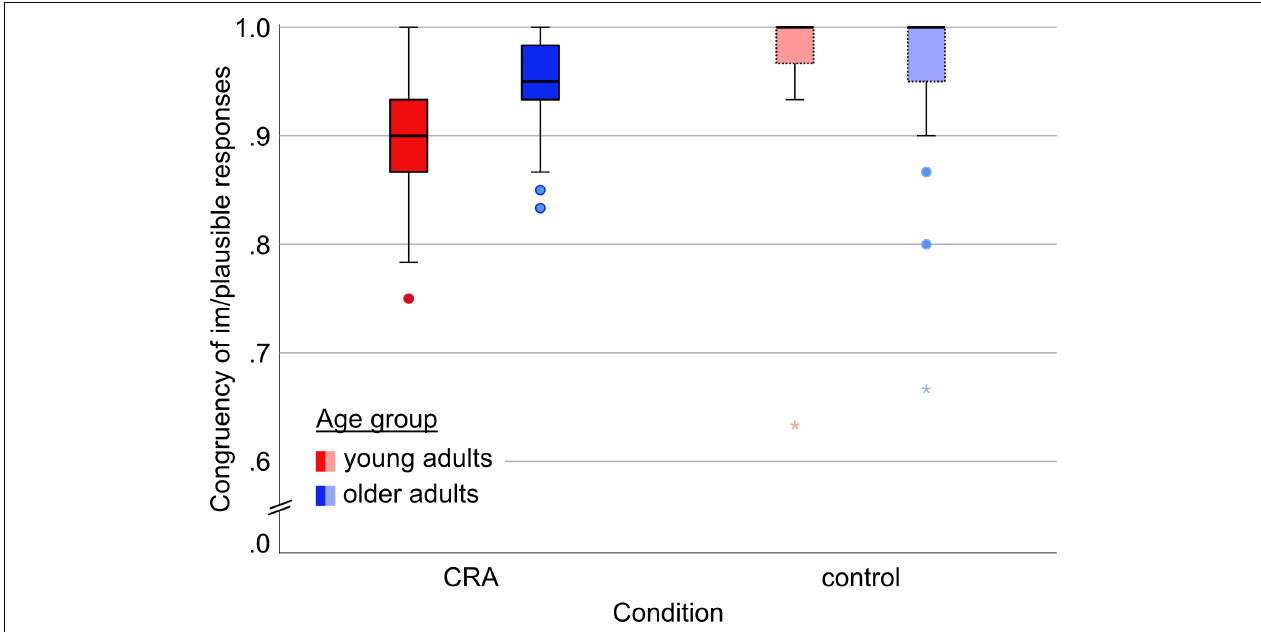
FIGURE 2 | Frequency of congruent responses of the plausibility decision by condition and by age group. Congruent responses: plausible CRA and implausible control.